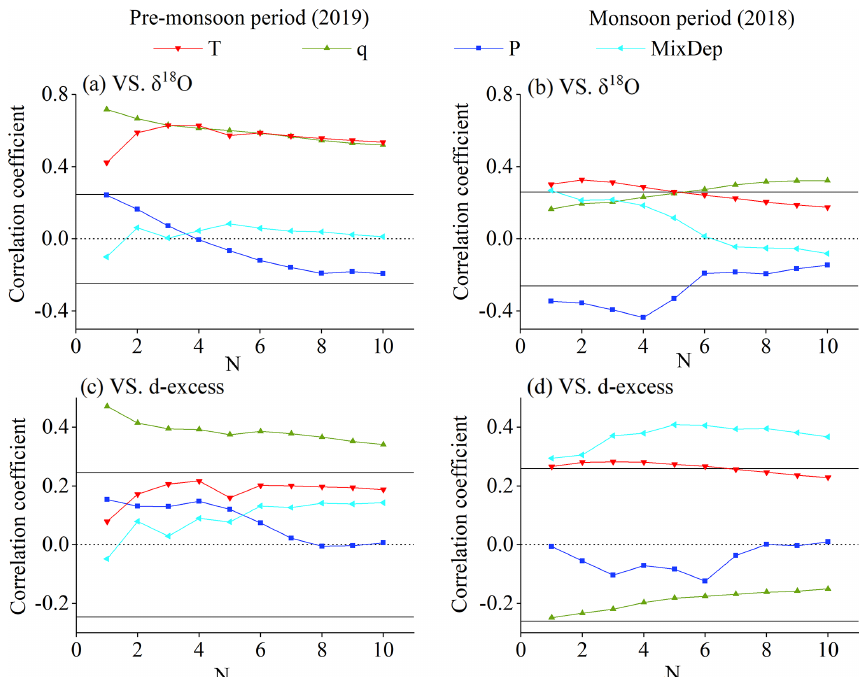
Figure 11. Correlation between δ 18 O (a, b) , d-excess (c, d) , and various meteorological factors (air temperature ( T ), specific humidity ( q ), precipitation ( P ), and mixing depth (MixDep)) along the air mass trajectories during the pre-monsoon period (a, c) and monsoon period (b, d) . The x axis “N” represents the number of days prior to the observations (from 1 to 10d). For example, when the number of days is 2, the correlations are calculated with the temporal mean of meteorological data along the air mass trajectories during the 2d before the observations. Horizontal solid lines indicate the correlation threshold for statistical significance ( p< 0 .